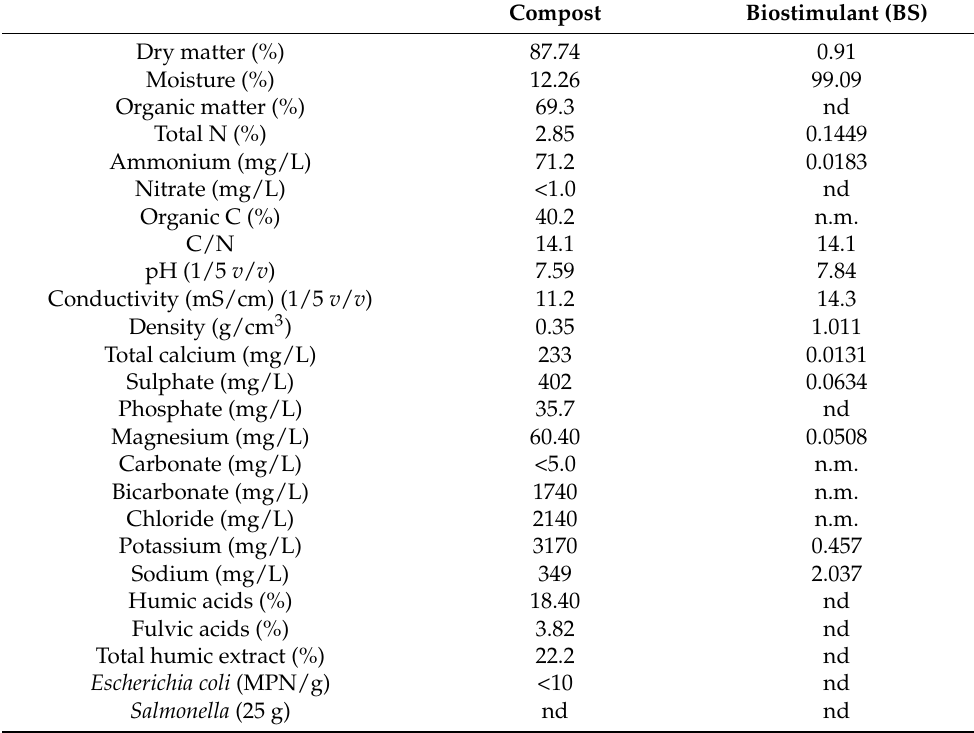
Table 1. Physicochemical characteristics of compost and biostimulant (n.m., not measured; nd, not detected; MPN, most probable